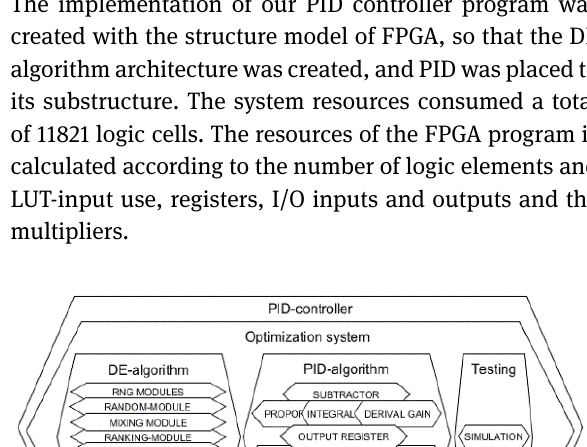
In figure 4 FSM module responses to the user